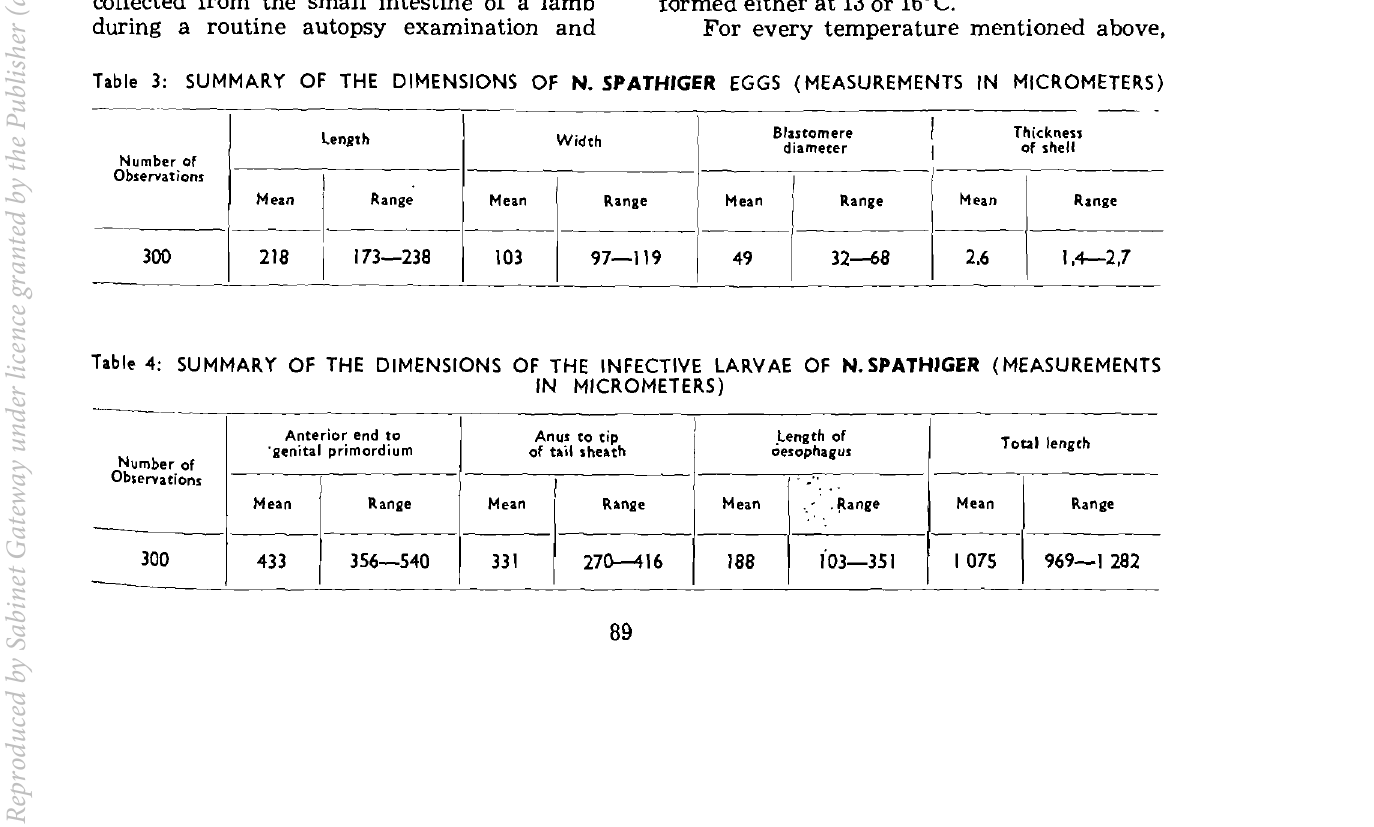
Table 3: SUMMARY OF THE DIMENSIONS OF N. SPATHIGER EGGS (MEASUREMENTS IN MICROMETERS)